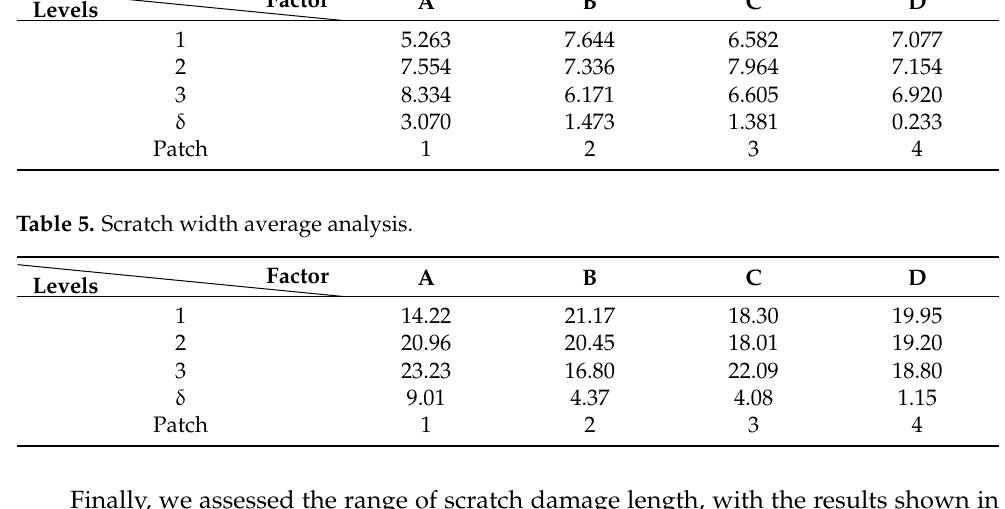
Table 6. After comparing the calculation results for the same factor at different levels, the